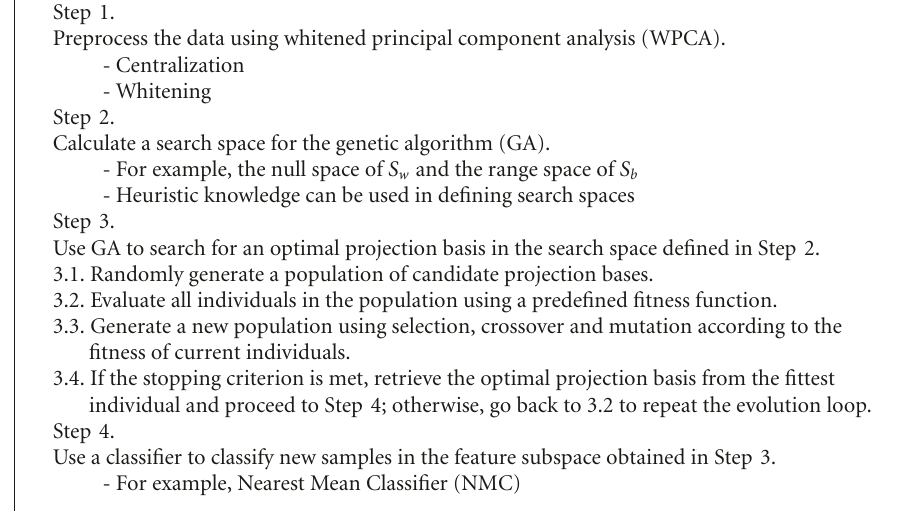
Algorithm 1: Procedures of the proposed EDFE